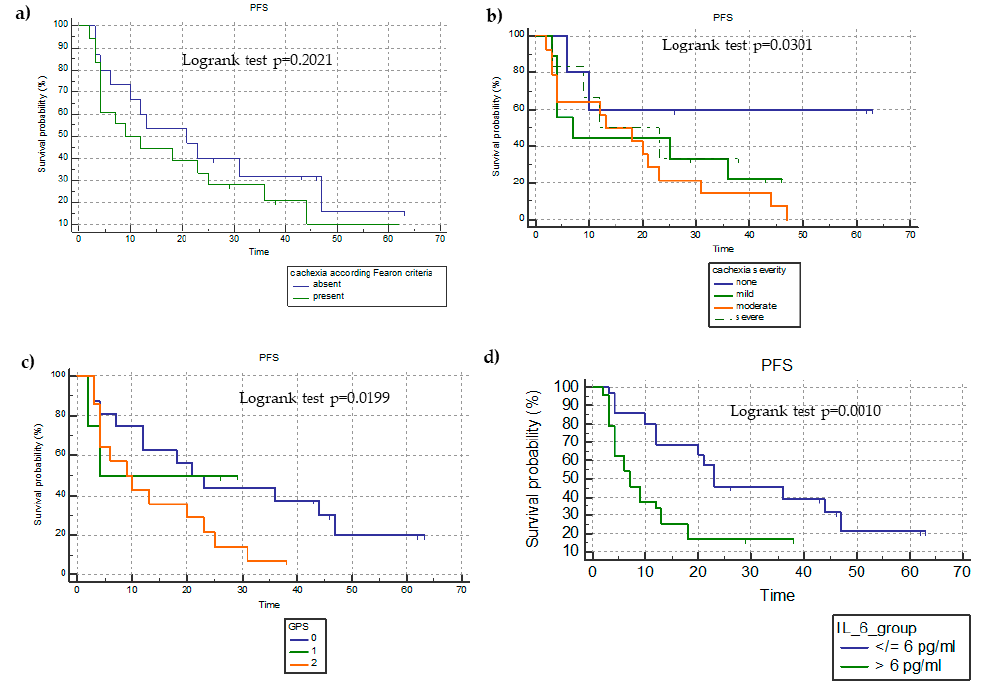
Figure 2. Kaplan–Meyer survival analysis of progression-free survival (PFS) in terms of the presence of cachexia ( a ), miniCASCO-based cachexia severity ( b ), GPS categories ( c ), and IL-6 median level of cachexia ( a ), miniCASCO‑based cachexia severity( b ), GPS categories ( c ), and IL‑6 median level ( d ( d ).